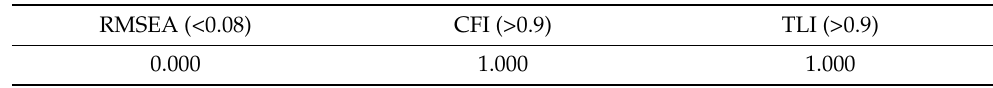
Table 3. The model fitting effect of path analysis.